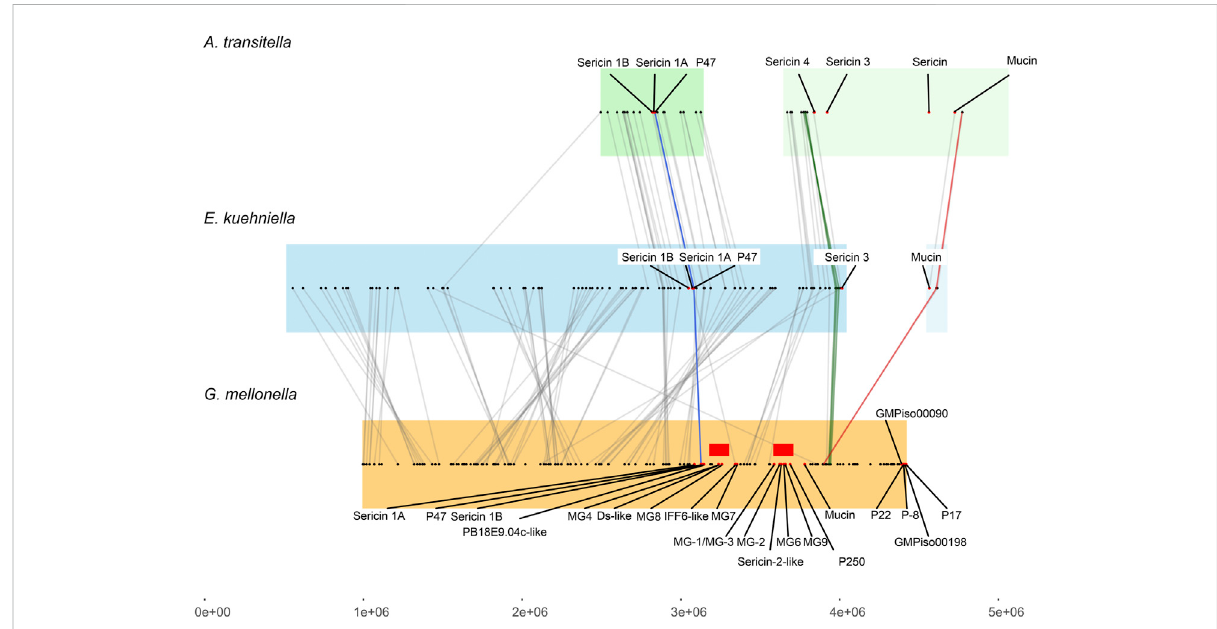
FIGURE 5 Collinearity analysis of sericin genes among E. kuehniella , G. mellonella , and A. transitella . Collinear blocks are highlighted with background colors.Silkgenesareindicatedwithreddots.Redrectanglesindicatetheareaofthe G.mellonella genomecontainingrecentlyduplicatedsilkgenes. The color and gray lines connect the syntenic gene pairs. The proposed “ landmark ” genes (see Supplementary Table S5 for gene names) that are adjacent to the silk genes in three species are connected with blue, green and magenta lines.